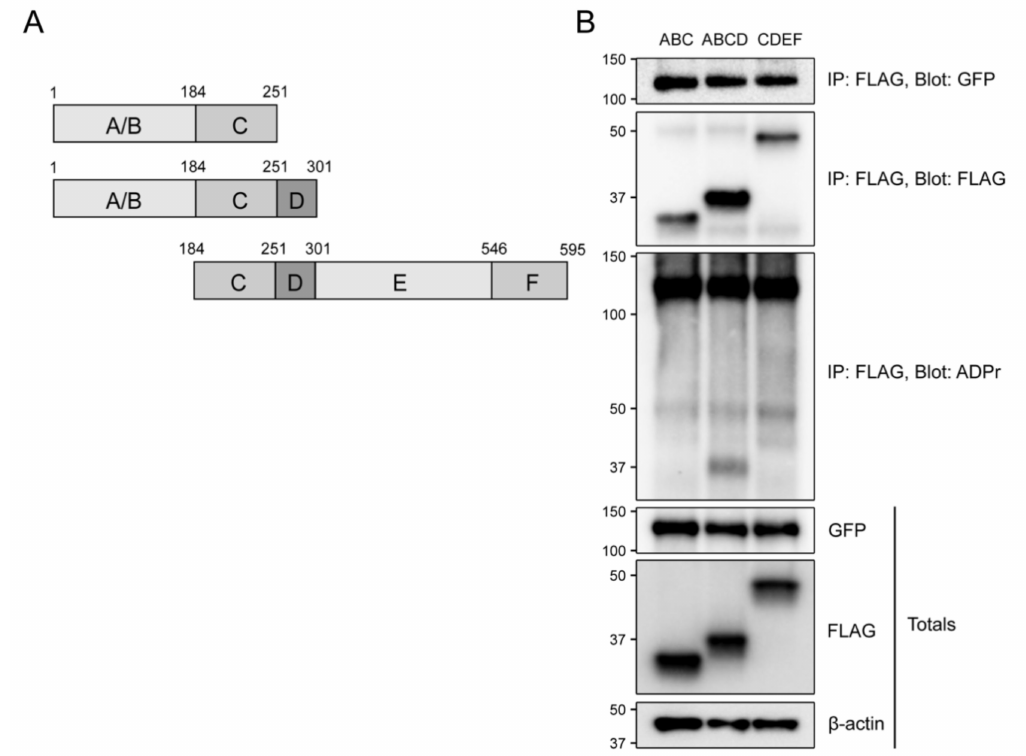
Figure 7. The hinge region of ER α is required for mono-ADP-ribosylation by PARP7. ( A ) A schematic representation of the truncated variants of ER α . ( B) PARP7 co-immunoprecipitated with all three ER α variants. Only ER α ABCD was mono-ADP-ribosylated. COS-1 cells were transfected with GFP-PARP7 and either 3xFLAG-ER α ABC, 3xFLAG-ER α ABCD, 3xFLAG-ER α CDEF. Co-immunoprecipitation was carried out with anti-FLAG, and membranes were blotted with anti-FLAG, anti-GFP and